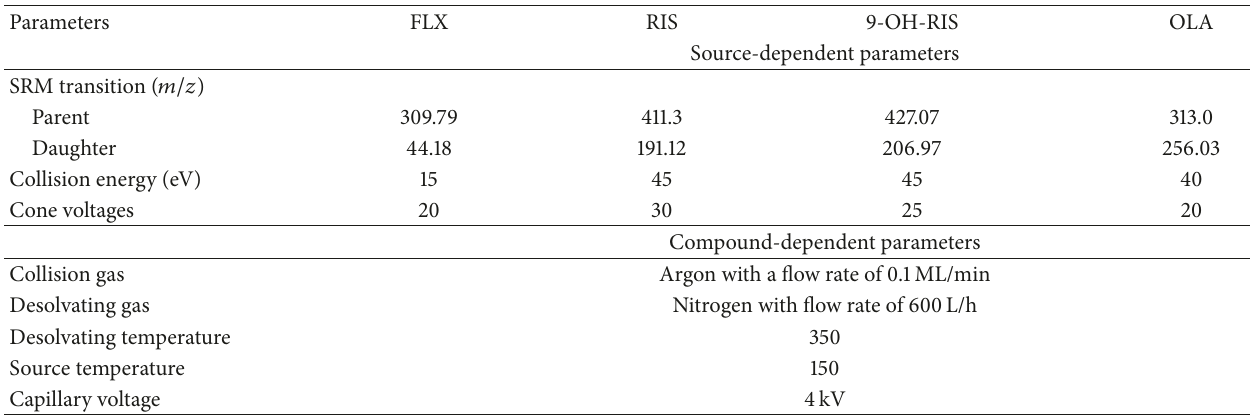
Figure 3: MRM chromatogram for FLX, RIS, and 9-OH-RIS and the IS (OLA) resulting from analysis of blank plasma. Table 1: Mass optimization parameters for FLX, RIS, 9-OH-RIS, and